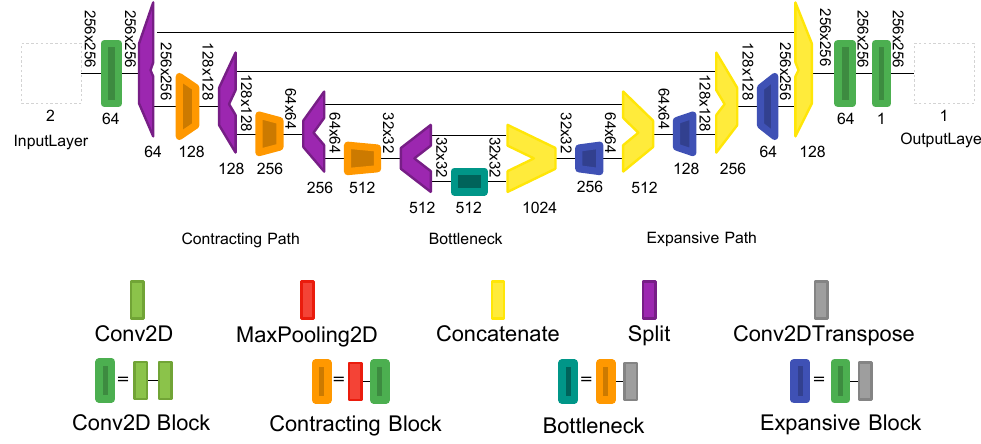
Figure 6. The proposed Noise Removal Subnetwork NR-SNet following a U-net